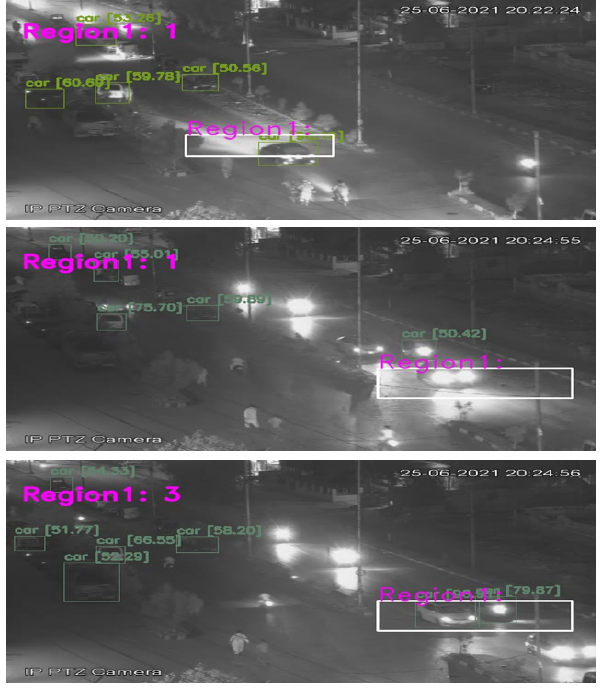
Figure 9. Detection of vehicles during the